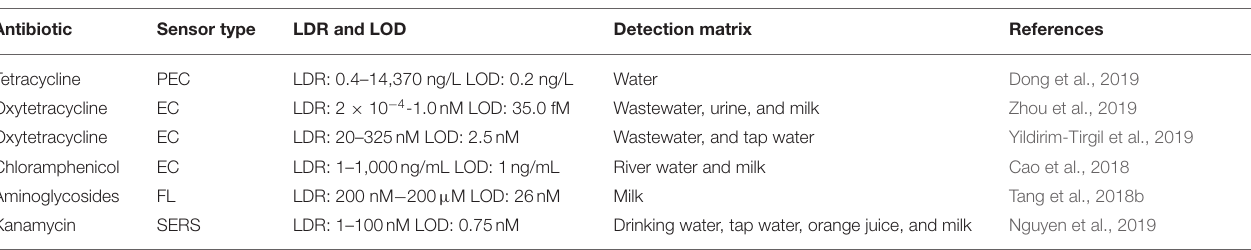
TABLE 3 | Aptamer-based biosensors for the detection of antibiotics in environmental water